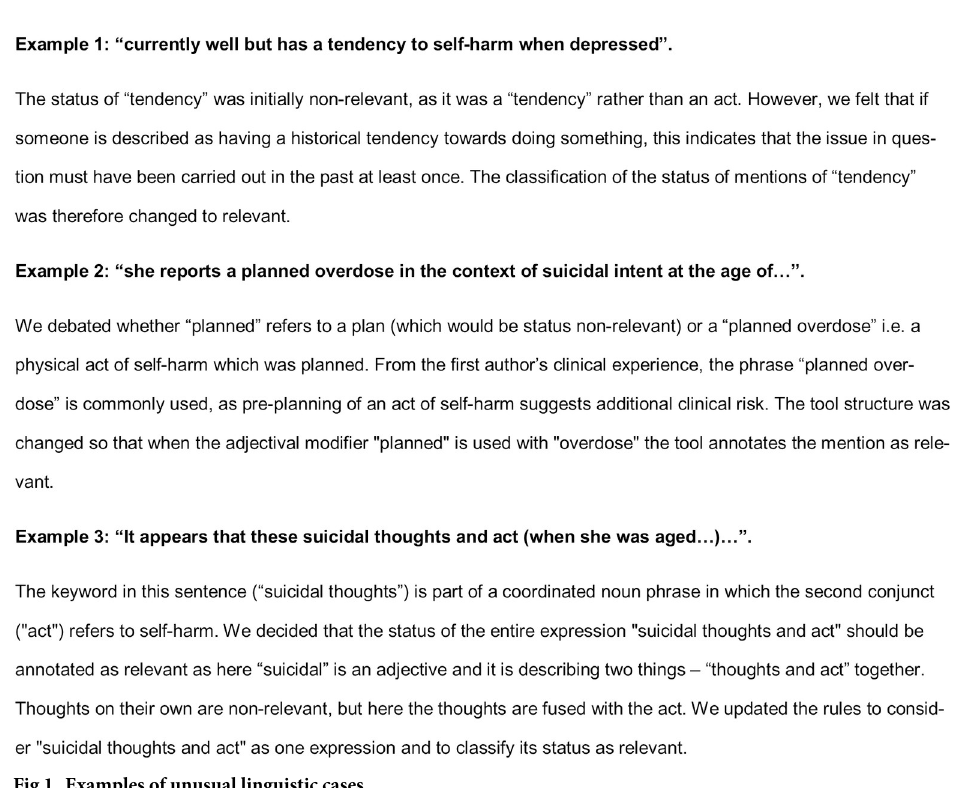
Fig 1. Examples of unusual linguistic